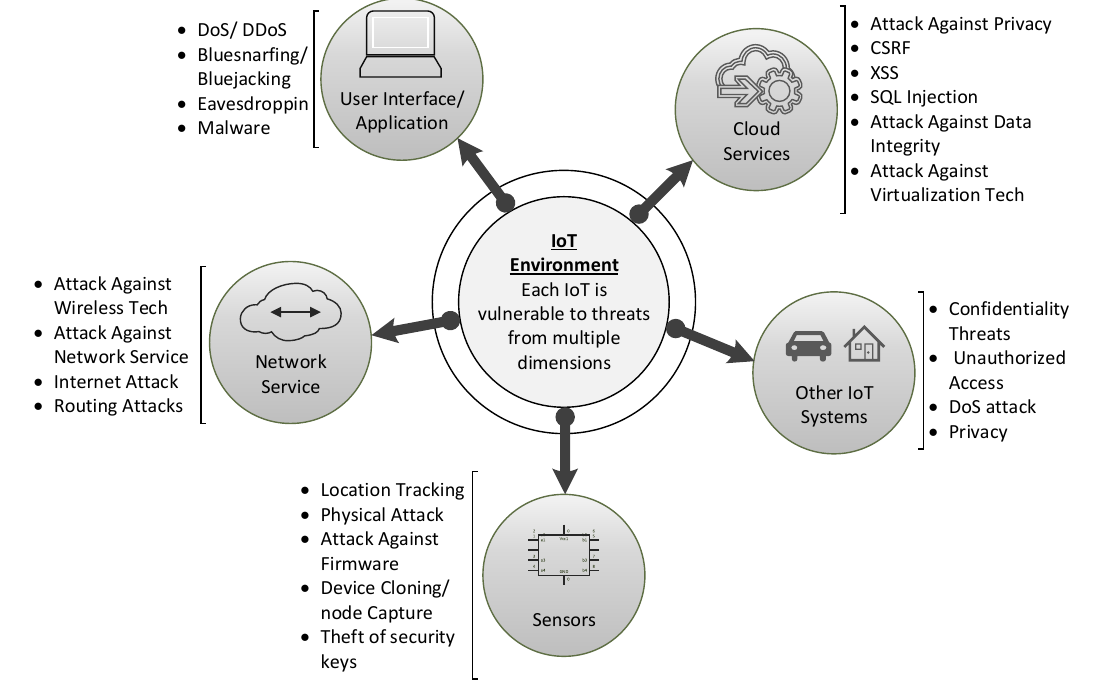
Figure 7. IoT environment threat